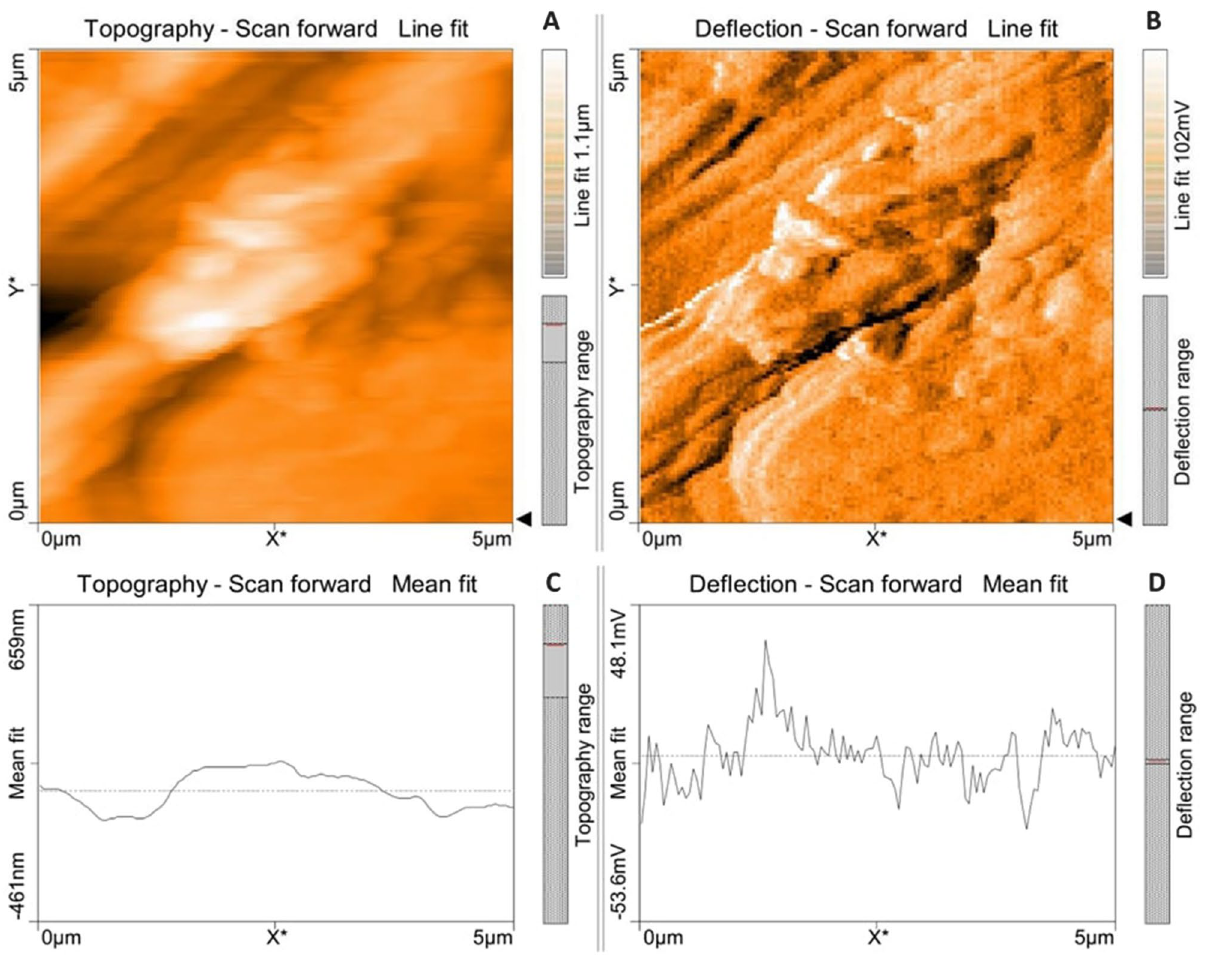
Figure 19. Atomic force microscopic results of microalga U. africanum treated LDPE sheet of 5 µm 2 area: ( A ) Topography of the surface (Line fit); ( B ) Voltage deflection (Line fit); ( C ) Topography with mean fit; and ( D ) Voltage deflection with mean